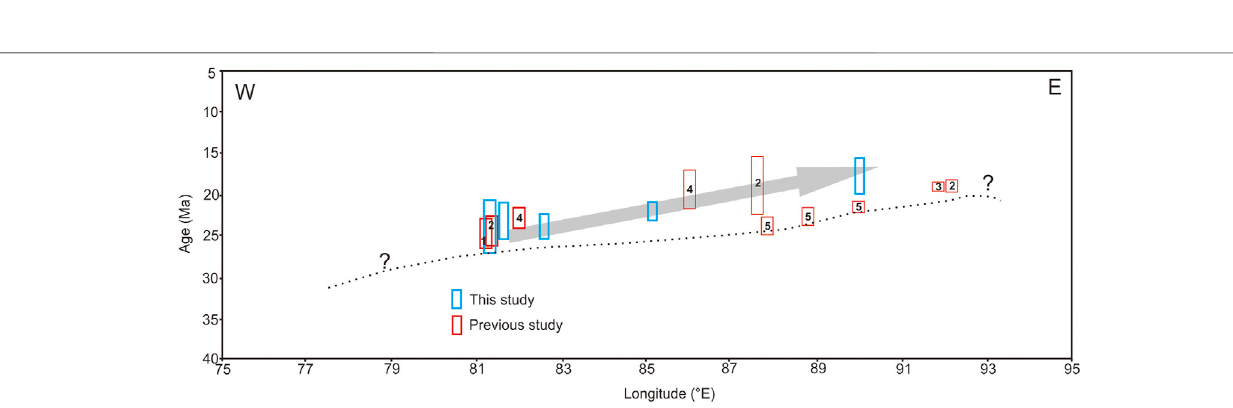
Frontiers in Earth Science |